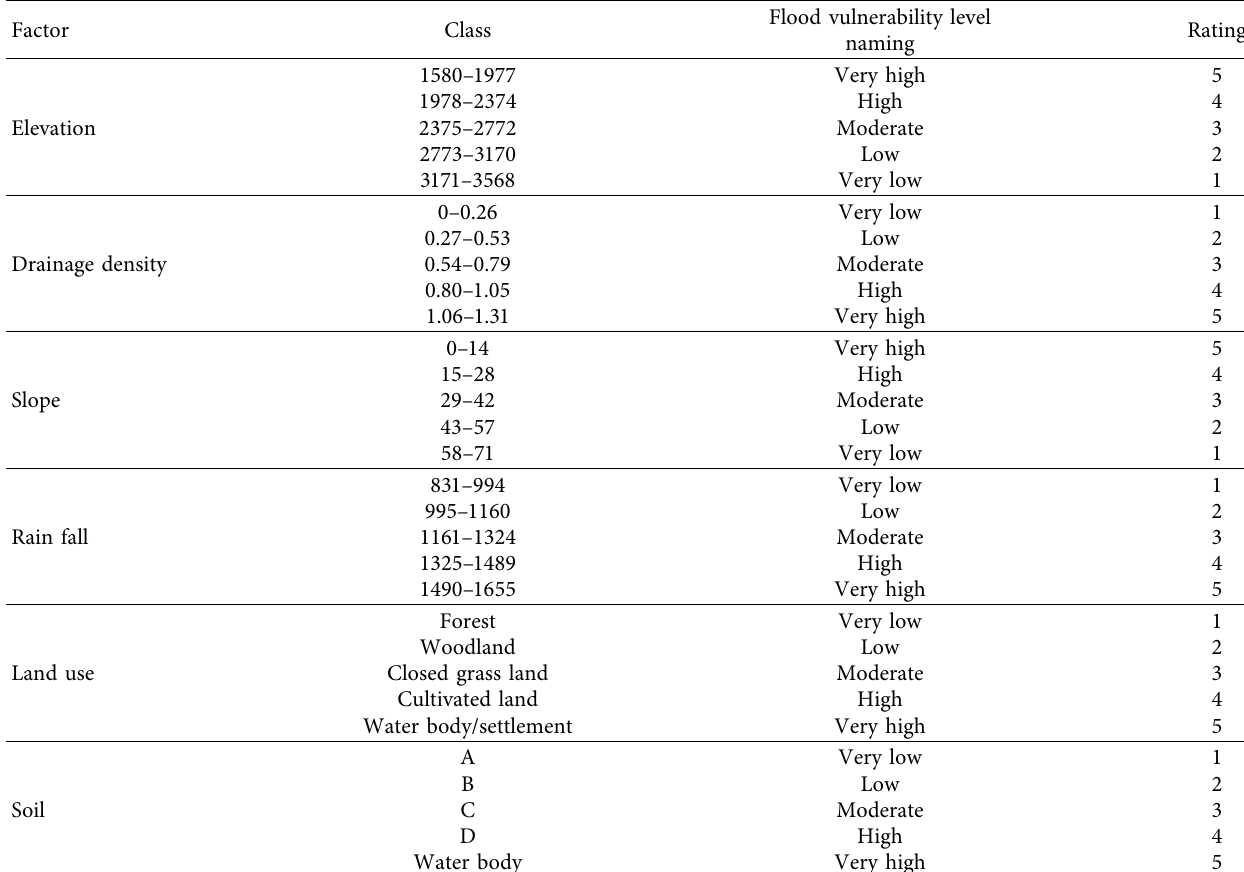
Table 1: Class and rating of food-generating factors.